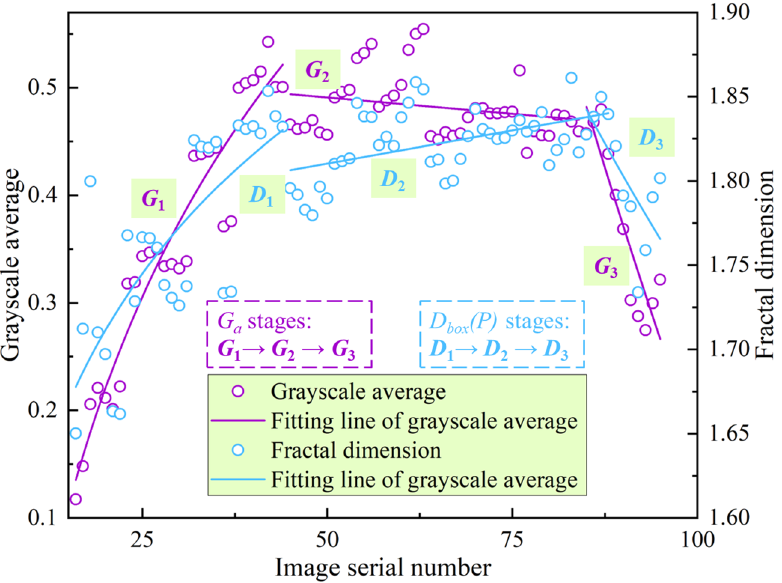
Figure 7. Calculating results of G a and D box (P) with corresponding fitting curves. G 1 , G 2 , G 3 and D 1 , D 2 , D 3 represent fitting curves of grayscale average and fractal dimension, respectively.